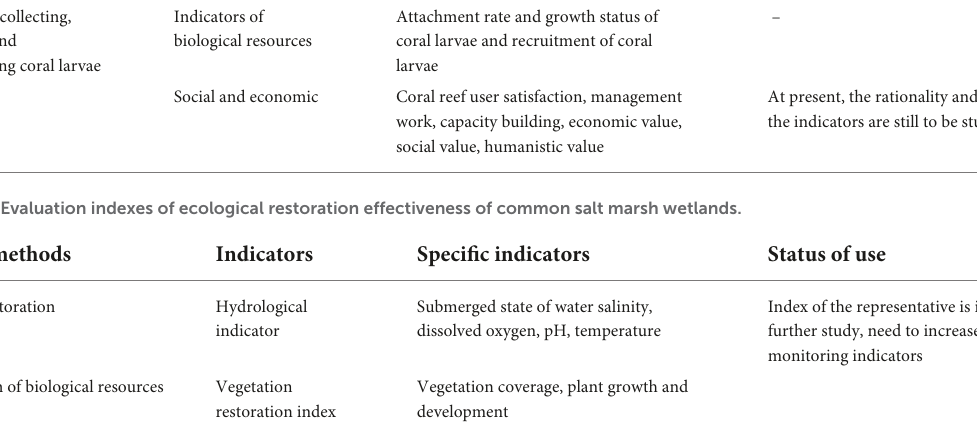
TABLE 4 Valuation method of ecosystem service